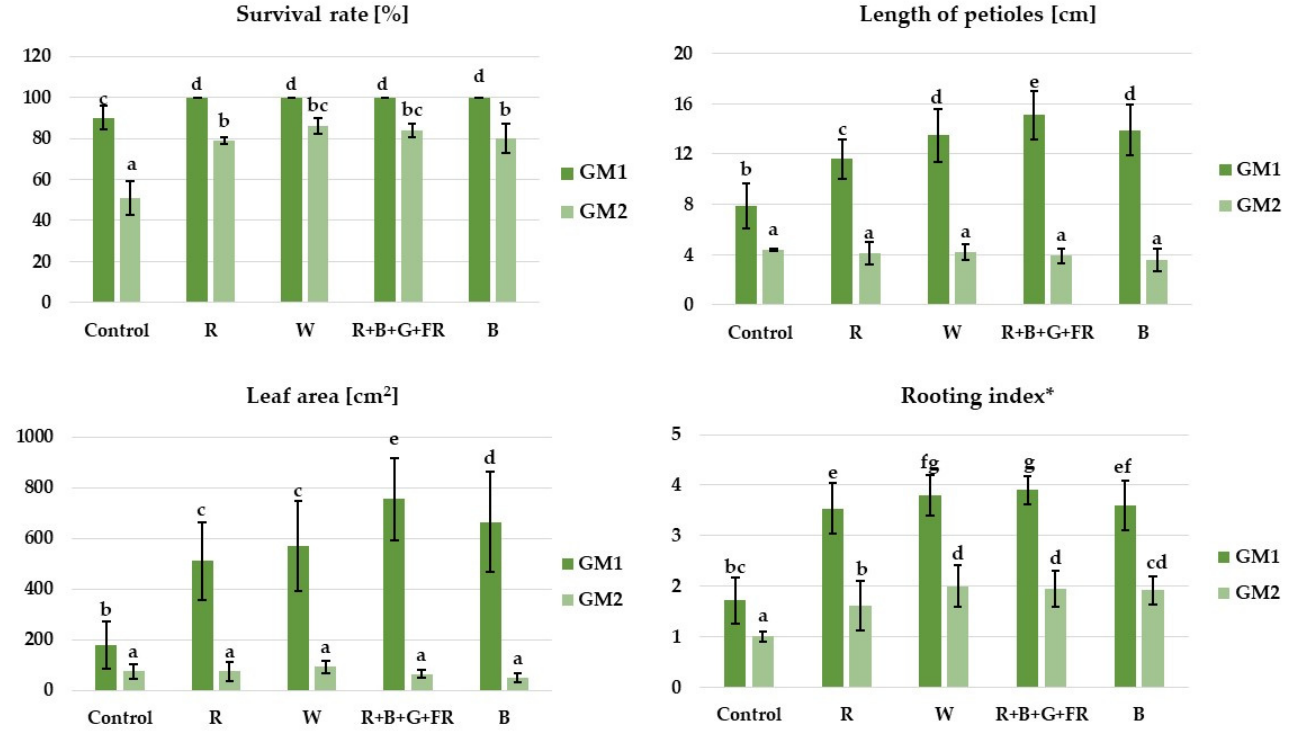
Figure 2. The effect of growth substrates (GM1—Floragard substrate; GM2—neutralised sphagnum peat) and supplementary lighting by different LEDs (control—natural light, R—red, W—white, B—blue, R+B+G+FR—far red) on the growth rate responses of Rheum rhaponticum ‘Raspberry’ after 6 weeks of growth under a 16-h photoperiod in the greenhouse. Bars represent means ± SE. According to Duncan’s test, the means of each growth parameter indicated with the same le tt er do not di ff er signi fi cantly.* root system assessment was conducted on a three-point scale: 1—no visible or single roots, 2—a poorly developed root, and 3—a well-developed root system.